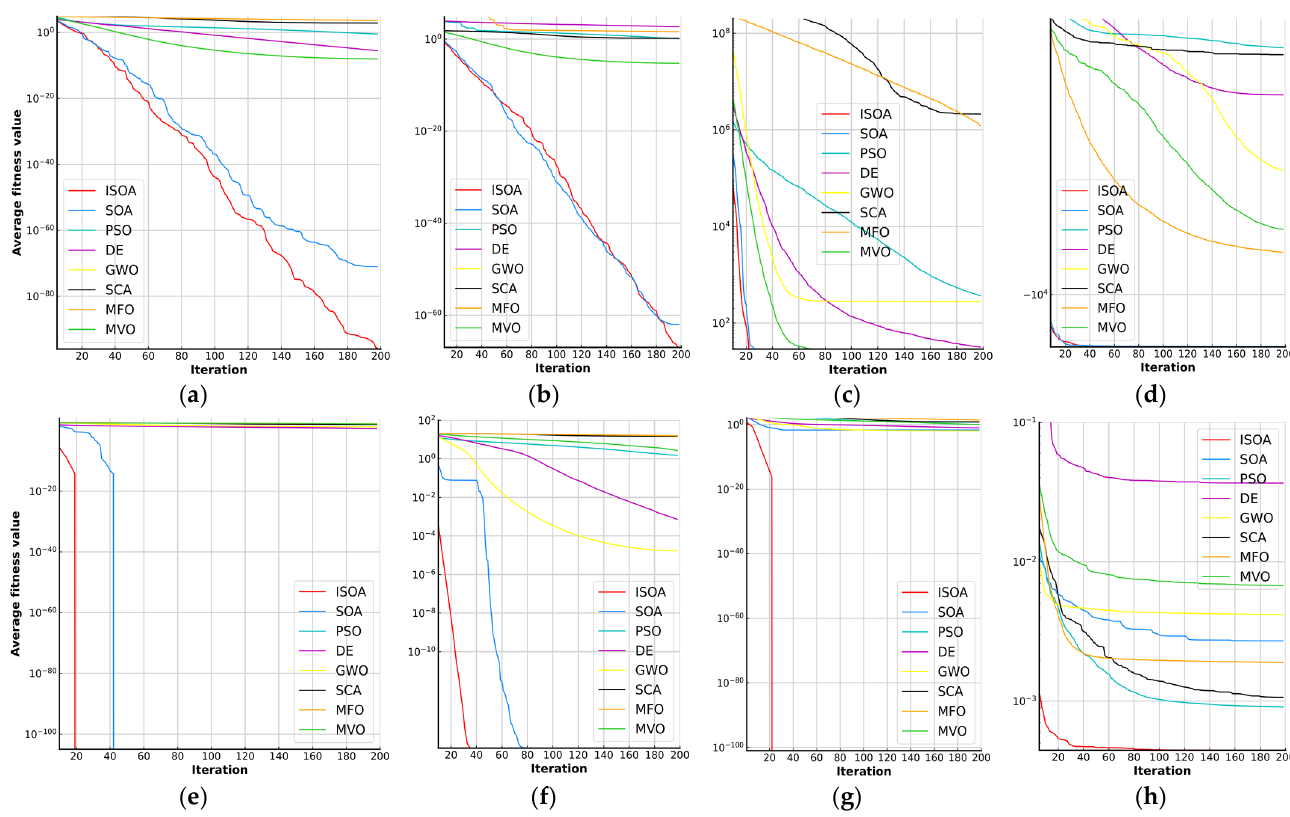
Figure 9. Convergence curves of ISOA, seagull optimization algorithm (SOA), particle swarm optimization (PSO), differential evolution (DE), gray wolf optimizer (GWO), sine cosine algorithm (SCA), moth flame optimization (MFO) and multiverse optimizer (MVO) tested on various benchmark functions. ( a ) F1; ( b ) F2; ( c ) F5; ( d ) F8; ( e ) F9; ( f ) F10; ( g ) F11; ( h ) F15. Table 6. Test results of 50 trials of ISOA and other algorithms.